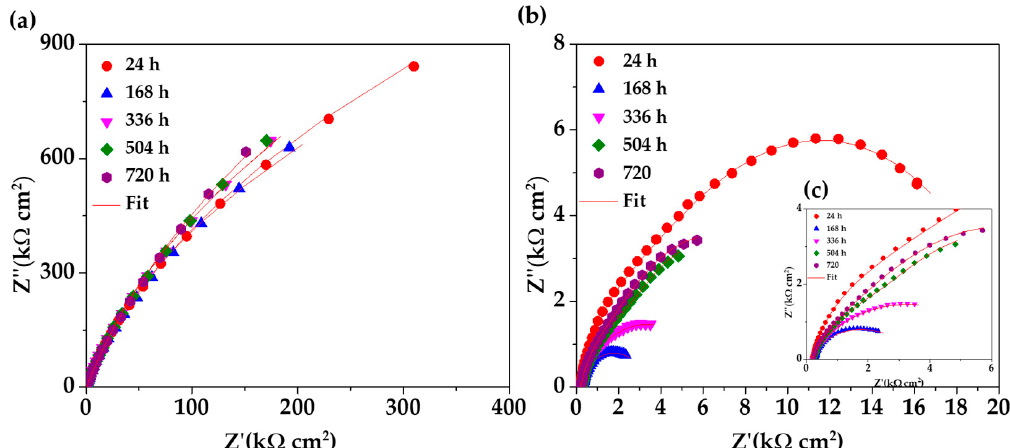
Figure 8. EIS Nyquist diagrams with a respective fitting line for SS 430 and carbon steel B450C after different times of immersion in chloride-containing (5 g L − 1 NaCl) cement extract solution: ( a ) SS 430, ( b ) B450C and ( c ) zoom of B450C ( b ) diagram.